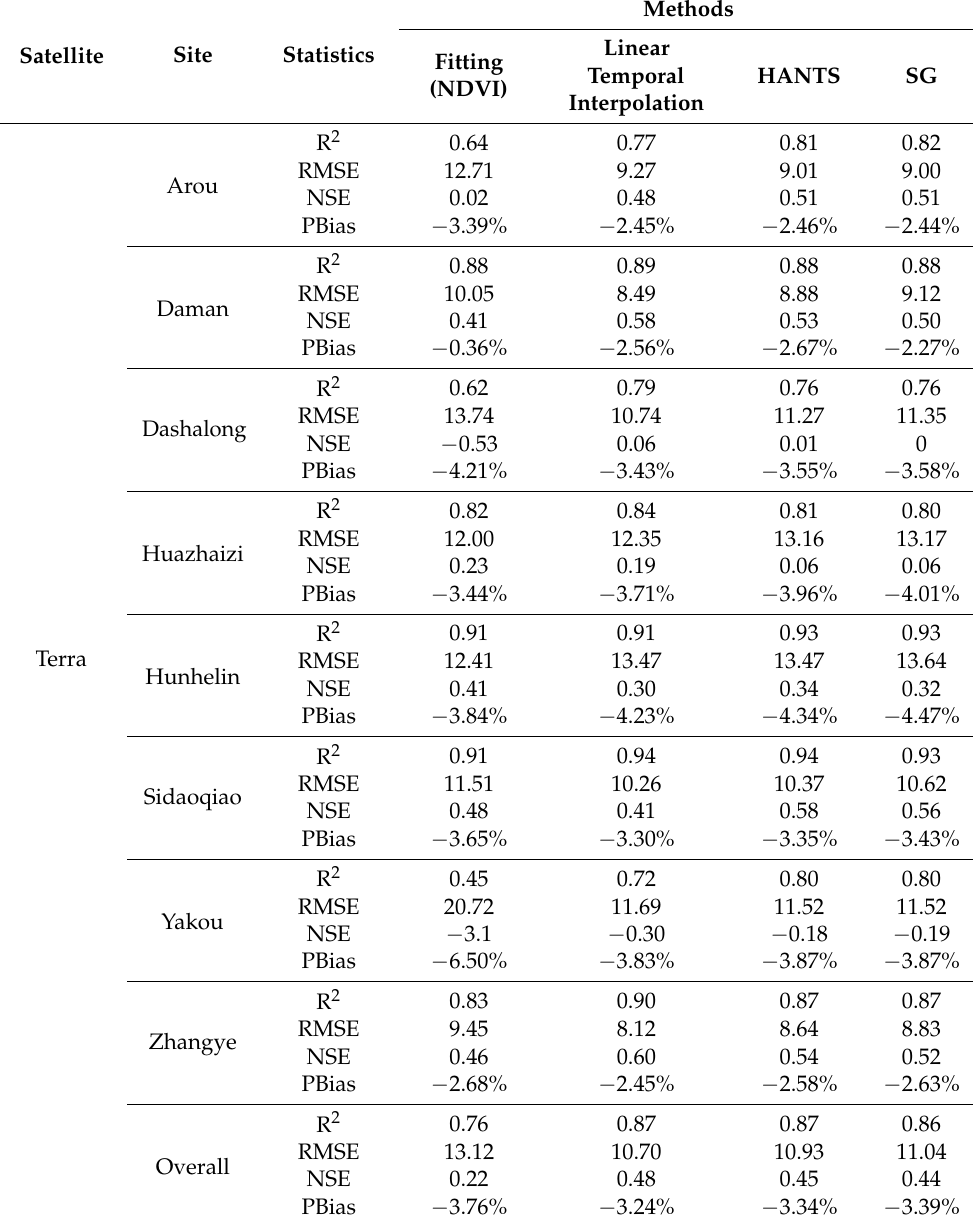
Table 2. The general performance results of reconstructed LST using the temporal and spatial methods based on Terra data from 2016 to